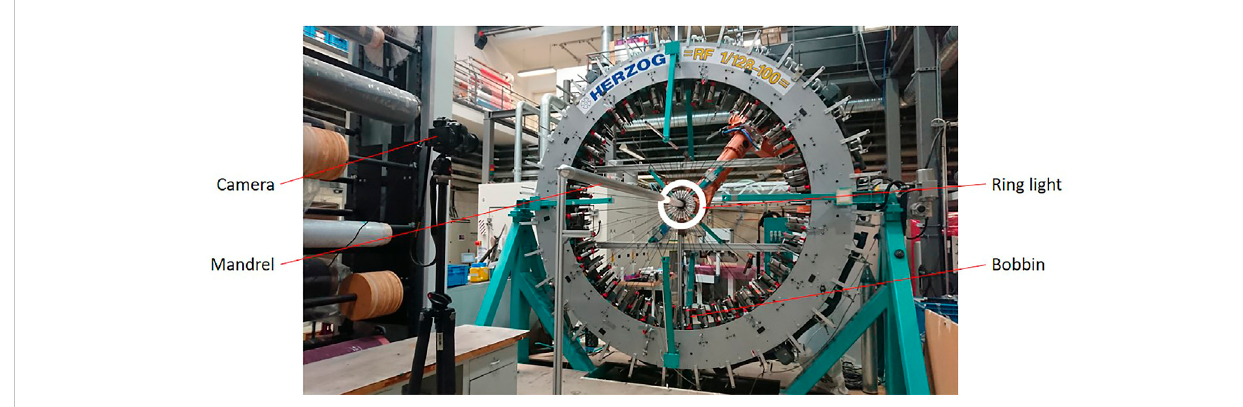
FIGURE 3 Experimental setup of the RF 1/128 – 100 braiding machine from HERZOG GmbH equipped with a ring light behind the braid formation zone, a cylindrical mandrel that is overbraided with carbon yarns and a camera that monitors the illuminated braid formation zone.